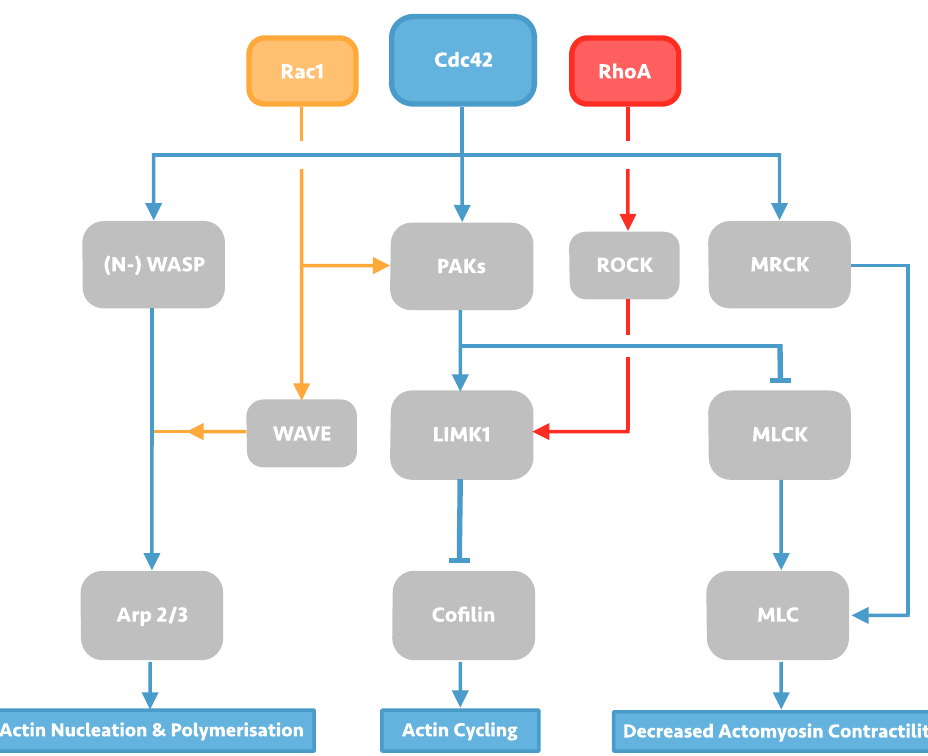
Figure 1. Overview of Rho GTPase signalling, with a focus on Cdc42 signalling. Cdc42 signalling can affect changes in actin dynamics through its three downstream effectors: the actin-polymerising protein Arp2/3, Cofilin, and myosin light chain (MLC). Arp 2/3 activation takes place through activation of Wiskott-Alrdich syndrome (WASP) scaffolding proteins in Cdc42 signalling, but can also be activated by Rac1 via WASP-family verprolin-homologous protein (WAVE) proteins. Activated WASP/WAVE proteins induce Arp2/3-led actin nucleation and polymerisation, producing actin meshwork. Cofilin activity is induced by protein activated kinases (PAKs) signalling, which may also be induced by Rac1 signalling. Activated PAKs can then activate LIM domain kinase 1 (LIMK1), leading to subsequent Cofilin phosphorylation and inhibition of its actin-severing function; LIMK1 may also be activated by RhoA via the serine/threonine kinase ROCK. PAKs signalling can also cause decreased actomyosin contractility by phosphorylating myosin light chain kinase (MLCK), allowing myosin light chain (MLC) activation. Cdc42 is also capable of activating MLC directly through myotonic dystrophy kinase-related Cdc42-binding kinases (MRCK).